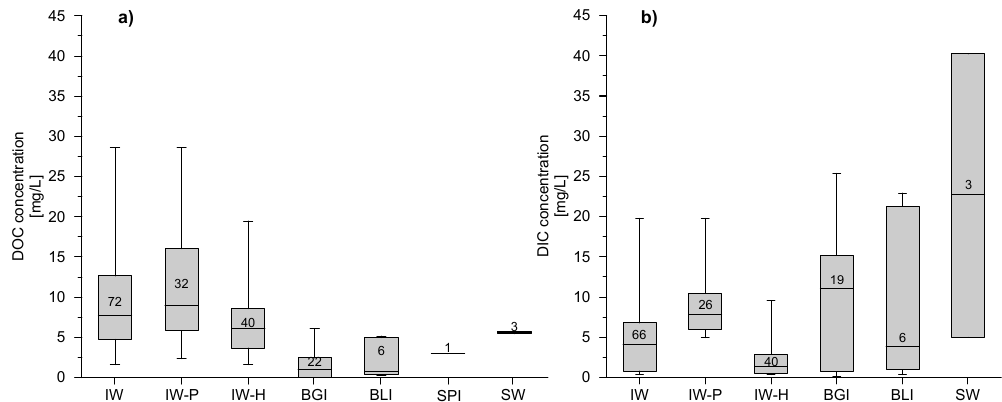
Figure 3. Boxplots of (a) DOC and (b) DIC concentrations in different massive ground-ice types. Plots show minimum, maximum and median values (25th percentile and 75th percentile as edge of boxes) and the number of samples in each category. IW: ice wedges (all), IW-P: Pleistocene ice wedges; IW-H: Holocene ice wedges; BGI: buried glacier ice; BLI: buried lake ice; SPI: snowpack ice; SW: surface water. For individual sample values see Table S1.